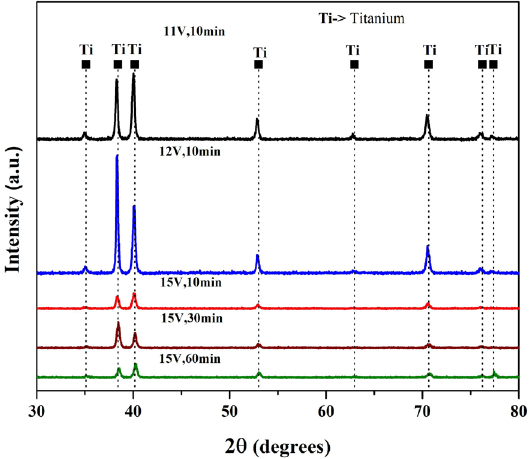
Figure 7. X-Ray diffraction patterns on the anodized titanium surface without thermic treatment.